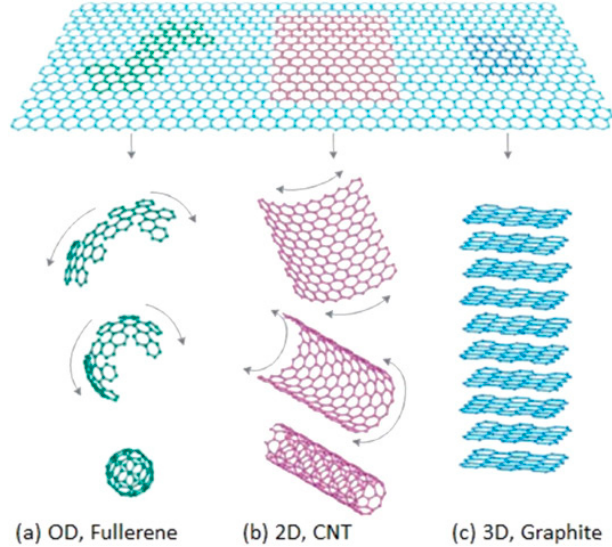
Figure 9. Graphene nanosheets can be transformed to ( a ) fullerene, ( b ) carbon nanotube, and ( c ) graphite [84].